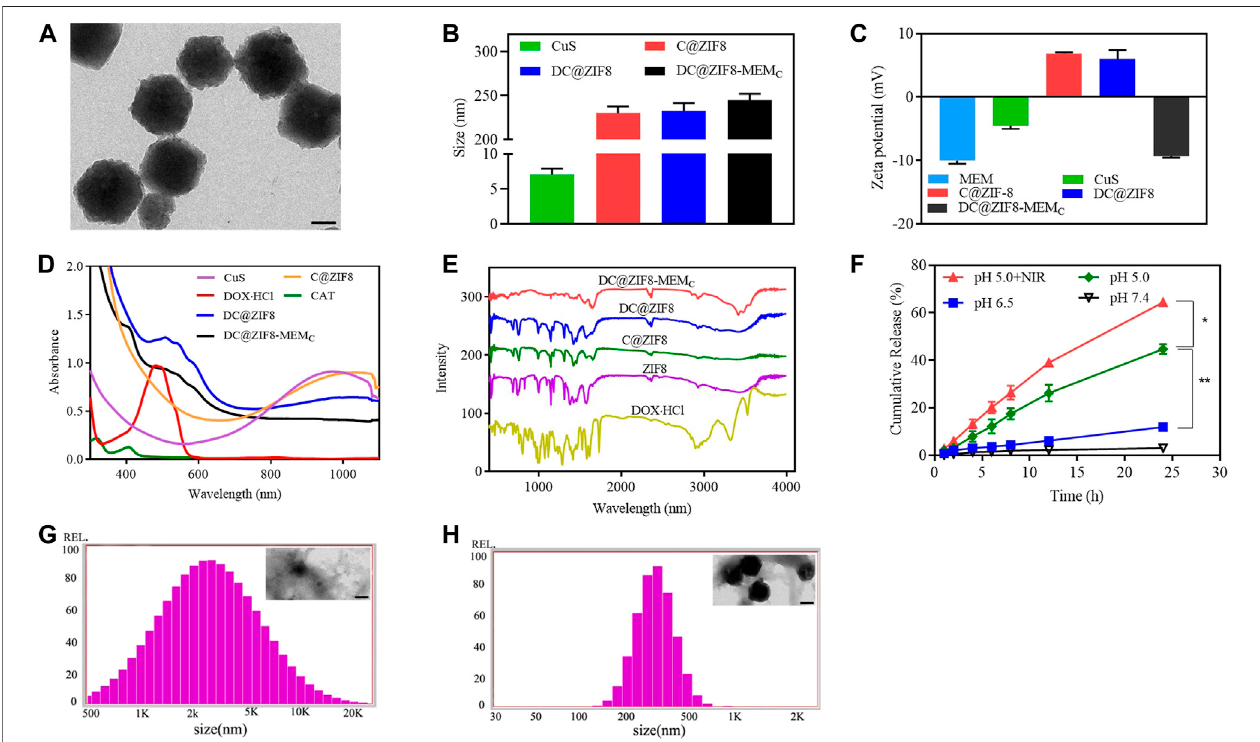
FIGURE2| Representativetransmissionelectron microscopy (TEM)imageofDC@ZIF8-MEM C (scalebar = 100 nm) (A) .Sizeofpreparations (B) .Zetapotentialof preparations (C) .Ultraviolet (UV)-visible(UV-Vis)analysis (D) .Fouriertransform infrared (FTIR)analysis (E) .DOX · HClrelease pro fi lesfromDC@ZIF8-MEM C underPBSat pHvaluesof5.0,6.5,and7.4 (F) .SizeandTEMimage(inserted)ofDC@ZIF8-MEM C withPBS(pH5.0)for8 h;scalebar = 100 nm (G) .SizeandTEMimage(inserted)of DC@ZIF8-MEM C with PBS (pH 7.4) for 8 h; scale bar = 100 nm (H)